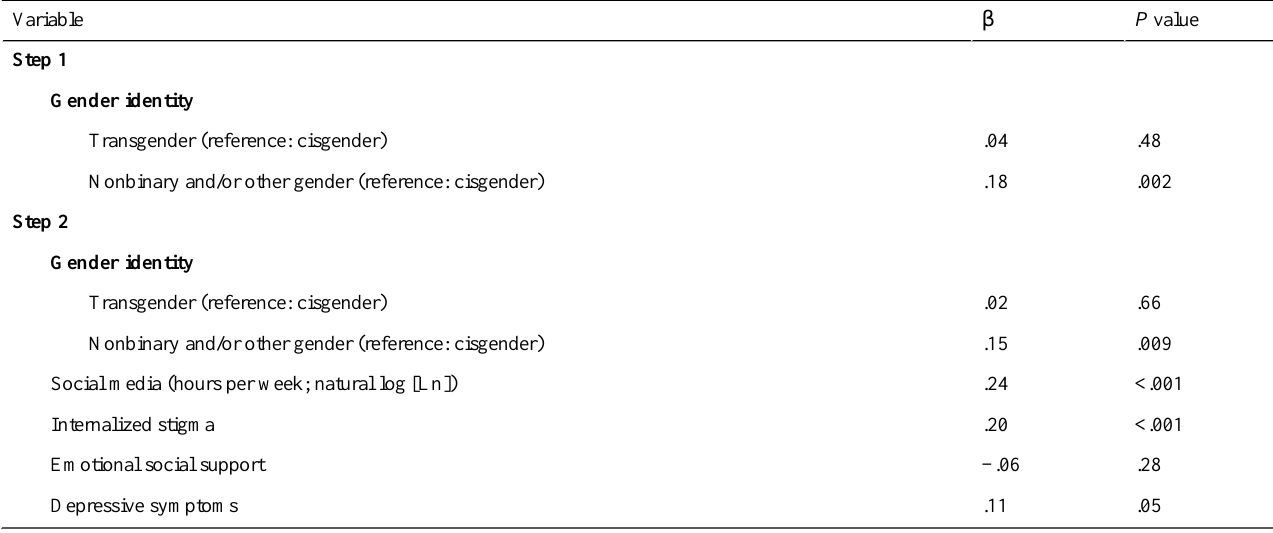
Table 4. Adjusted multiple linear regression analysis with problematic social media use as the outcome